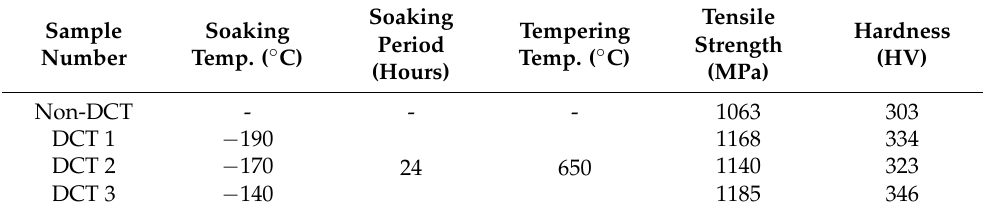
Table 3. Mechanical properties of EN 52 steel